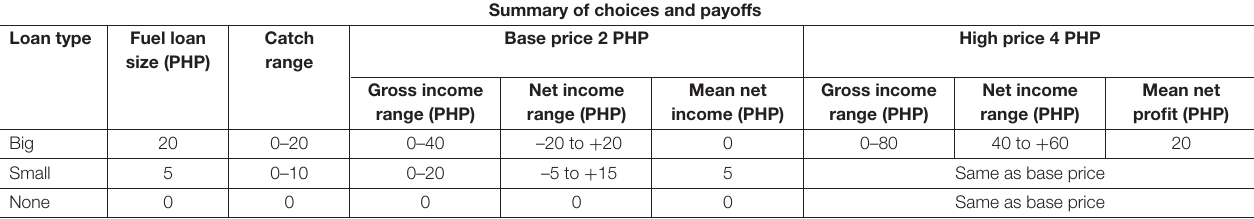
TABLE 3 | Summary of loan size, catches and incomes (payoffs) for each loan size option, with the base price, and the increased price in the experiment. Summary of choices and